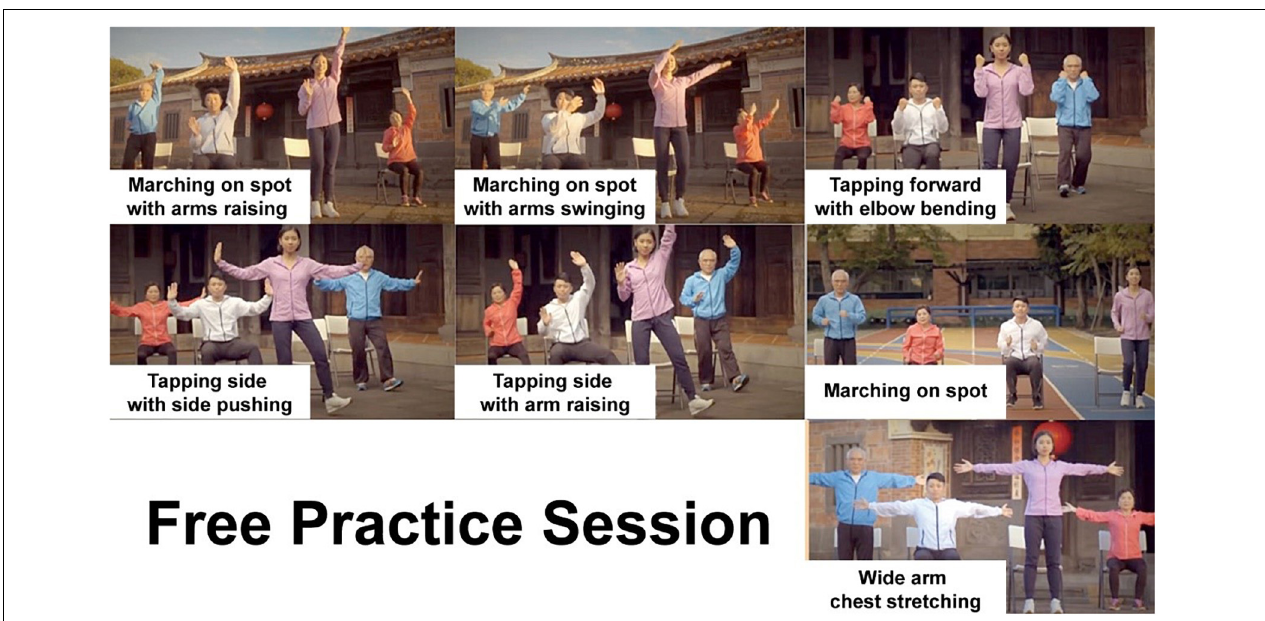
FIGURE 4 | The exercises featured in the